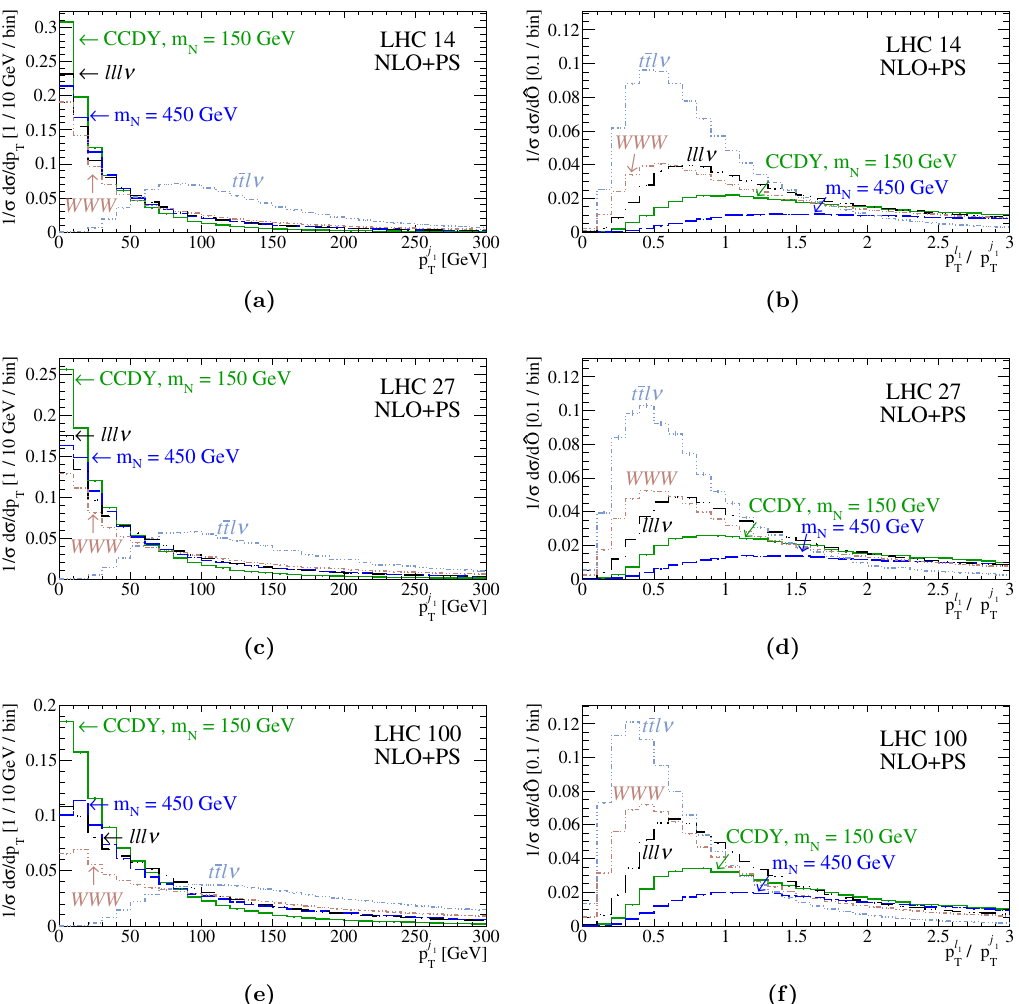
Figure 16. Normalized NLO+PS distributions with respect to (a,c,e) the p T of leading jet ( p j 1 and (b,d,f) the ratio of leading lepton p T ( p l 1 (c,d) 27 TeV, and (e,f) 100 TeV, for the charged current Drell-Yan (CCDY) pp process with m N = 150 GeV (solid) and 450 GeV (dash), as well as the pp pp WWW 3 ‘(cid:23) (dash-2 dots), and pp ! !